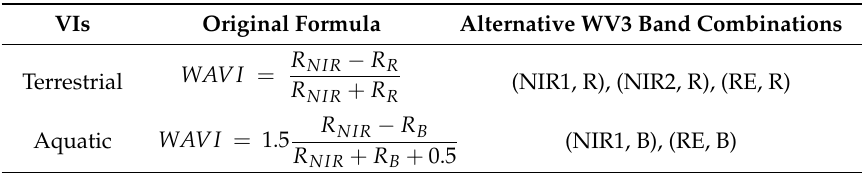
Table 3. Vegetation indices (VIs) used to study SAV. VIs Original Formula Alternative WV3 Band Combinations